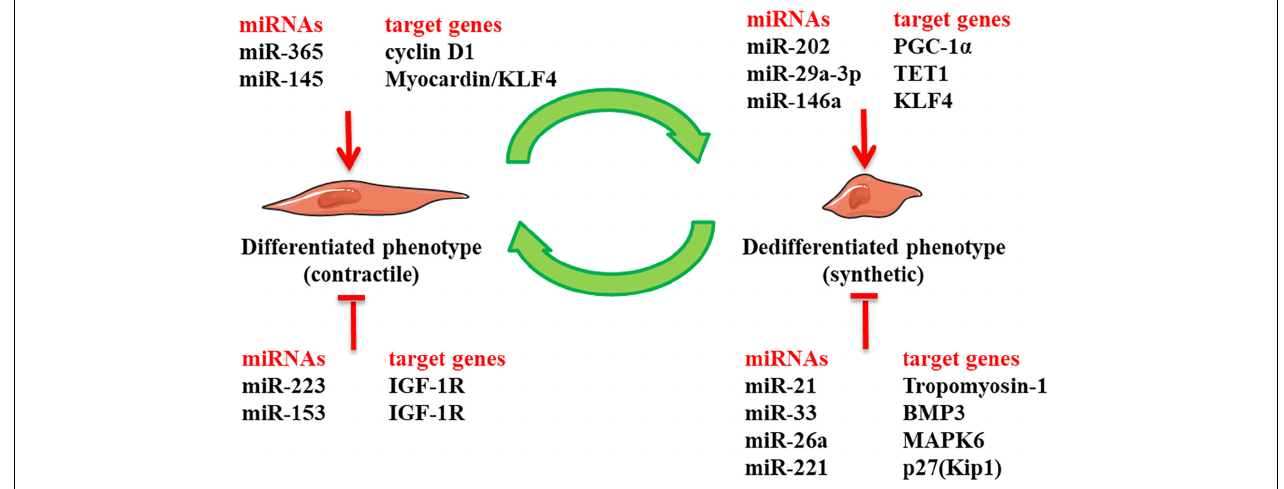
FIGURE 2 | The role of miRNAs in regulating phenotypic switch of venous smooth muscle cells (SMCs) in intimal hyperplasia of vein graft: it presents miRNAs that have been identified bearing regulatory effects on the phenotype of venous vascular smooth muscle cells (VSMCs) in intimal hyperplasia of vein graft. Klf4, Kruppl-like factor 4; IGF-1R, insulin-like growth factor-1 receptor; PCG-1 α , peroxisome proliferator-activated-receptor- γ coactivator-1 α ; TET1, Ten-eleven translocation methylcytosine dioxygenase 1; BMP3, bone morphogenetic protein 3; MAPK6, mitogen-Activated Protein Kinase 6; p27(Kip1), p27KIP1 gene.